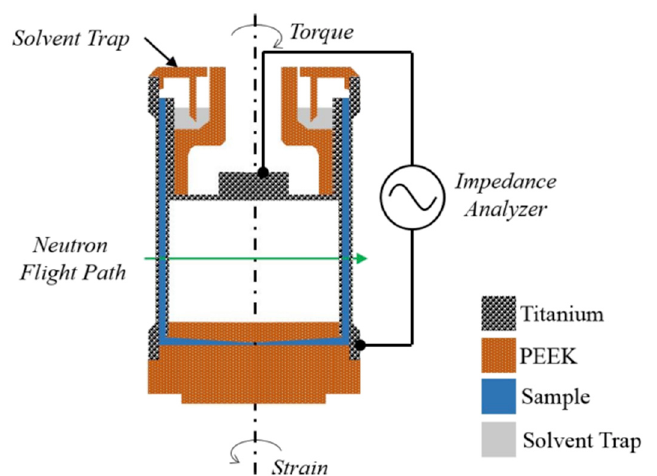
Figure 15. Schematic of a Couette rheology cell that allows for the simultaneous collection of rheo- logical, dielectric spectroscopy, and neutron scattering data. The electrical impedance is measured between the Ti cylinders. Temperature control is achieved by using a forced convection oven that surrounds the cell (reproduced with permission from [145], AIP Publishing, 2017).